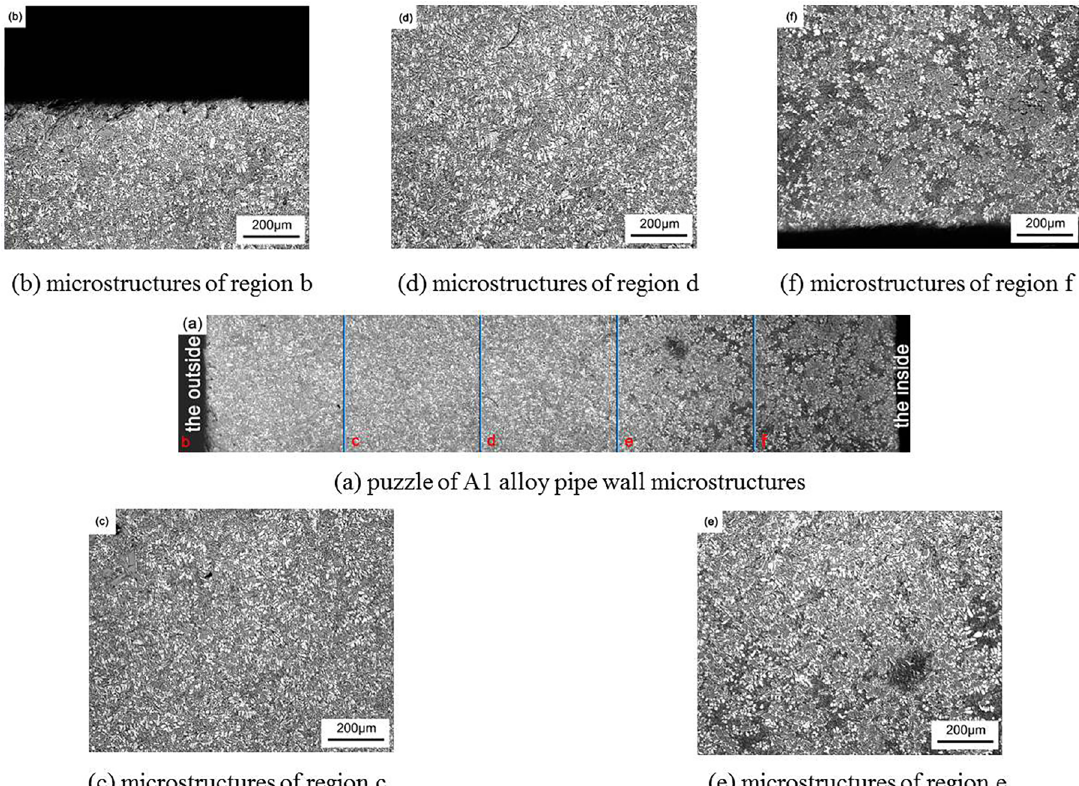
Figure 4. Rheo-squeeze casting A1 alloy pipe wall with gradient structure (a) puzzle of A1 alloy pipe wall microstructures; (b - f) microstructures of regions b -